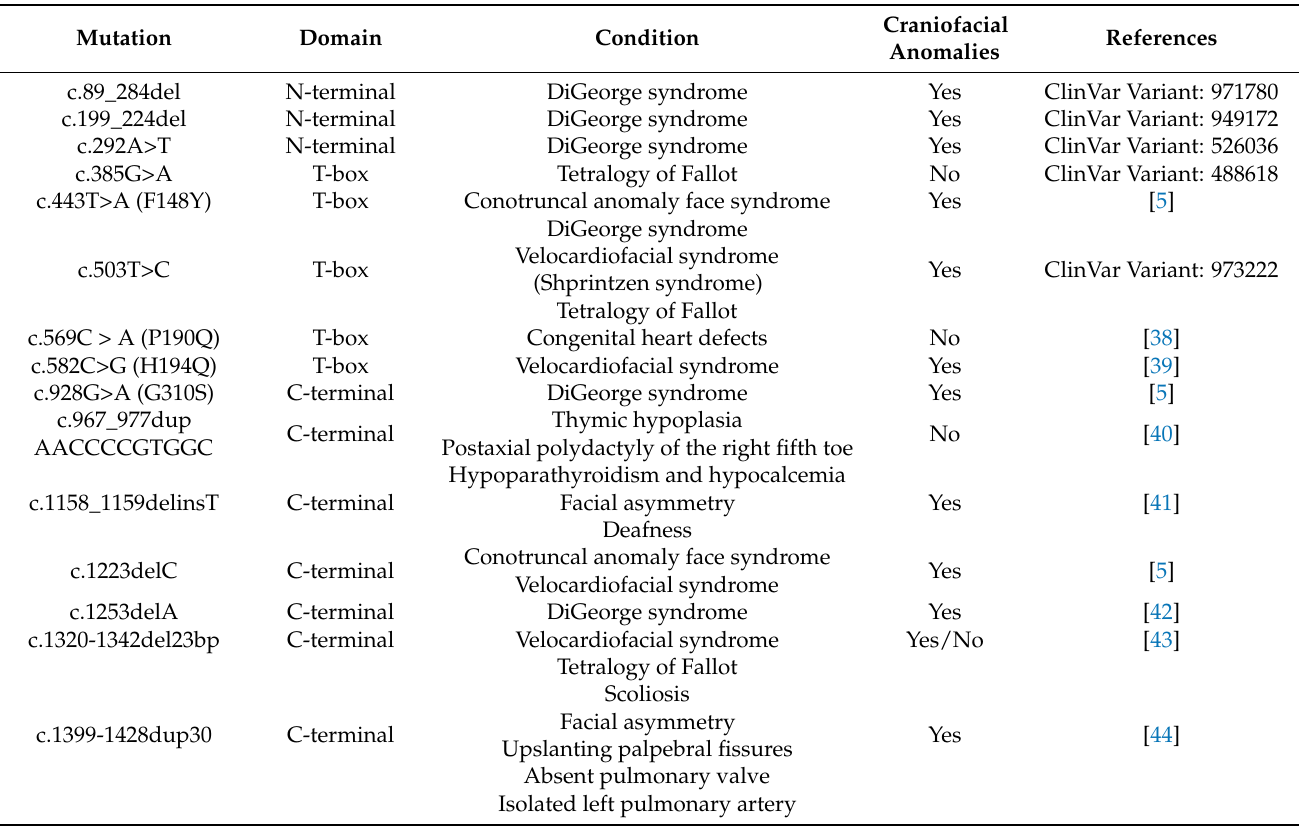
Table 3. DGS/VCFS-associated variants of